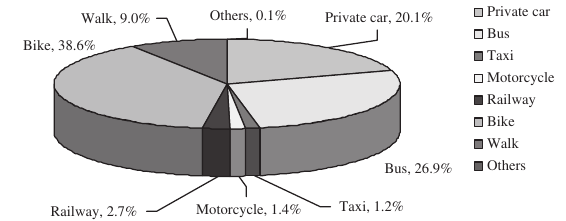
Fig. 1. Commute mode